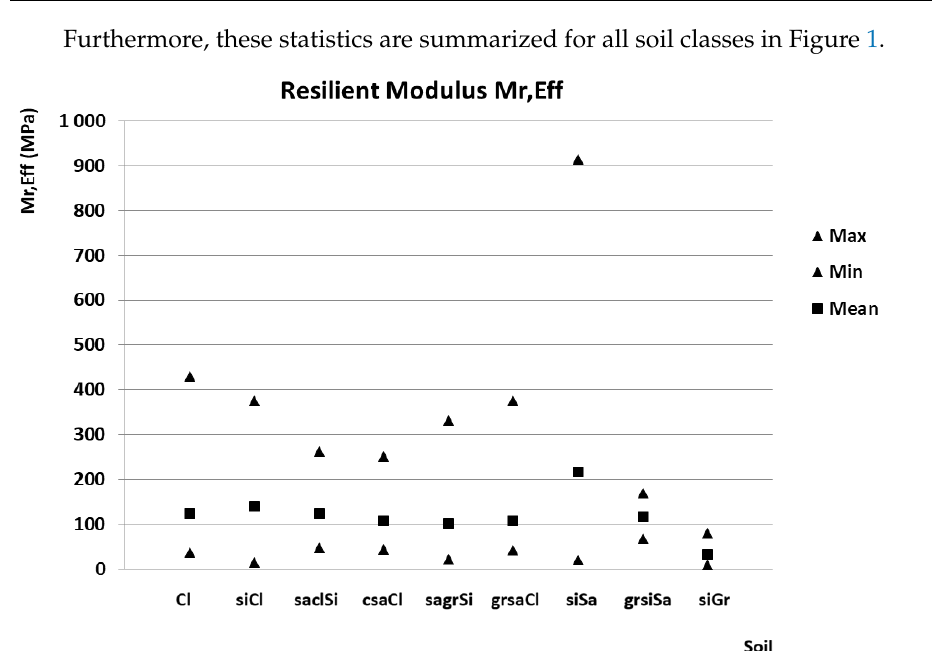
r,eff for individual soil